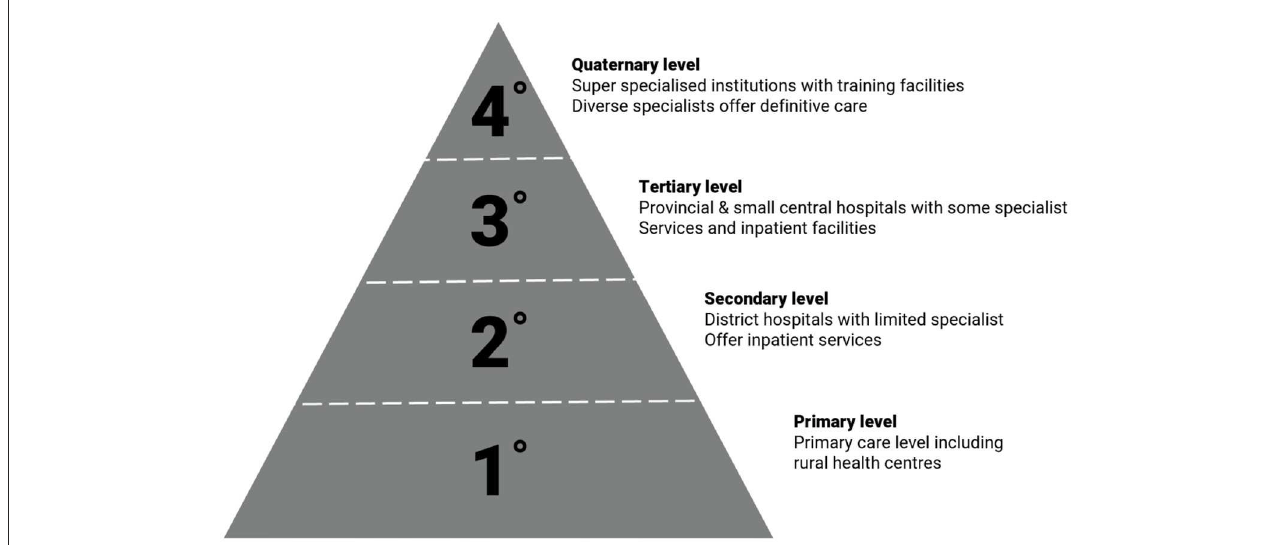
FIGURE2 Hierarchy of Zimbabwean healthcare facilities under the Ministry of Health